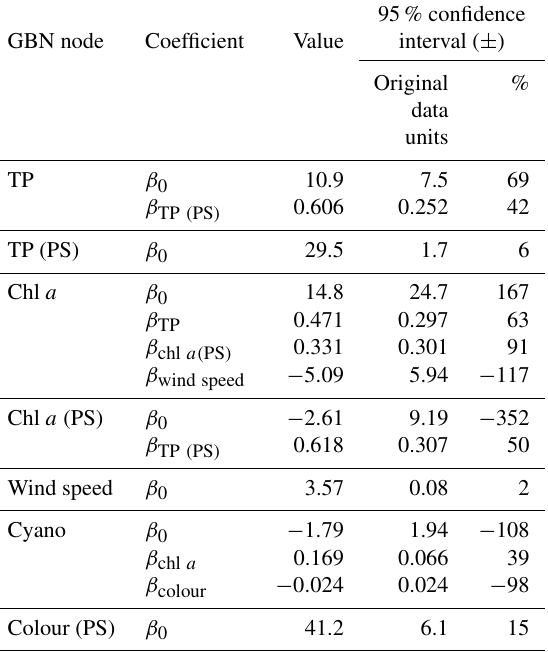
Table B1. Fitted GBN coefficients with 95% confidence